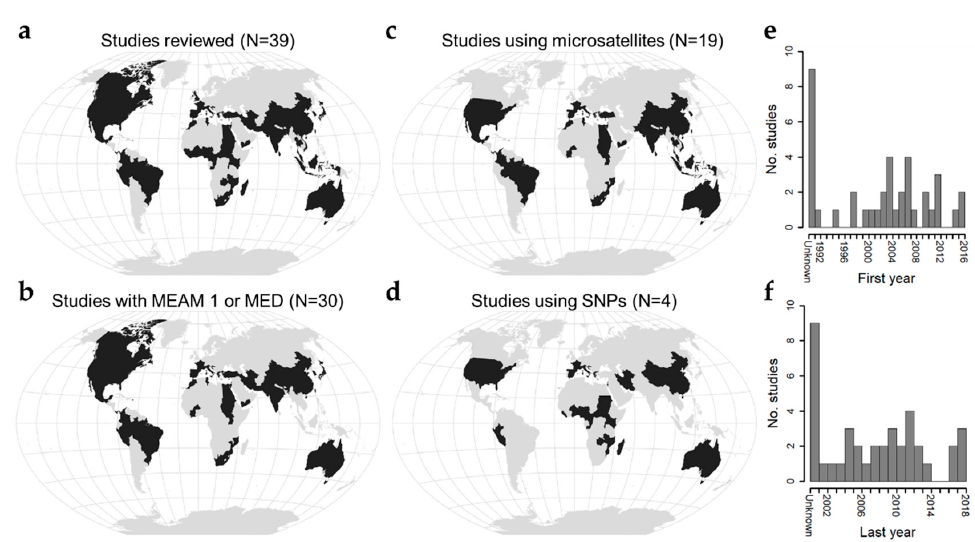
Figure 1. Geographic and temporal scope of literature reviewed. ( a ) Countries where Bemisia tabaci populations were sampled in the reviewed literature (number of studies = 39). ( b ) Countries where Middle East-Asia Minor 1 (MEAM 1) and / or Mediterranean (MED) cryptic species were sampled (number of studies = 30). ( c ) Countries where microsatellite data were used to study B. tabaci genetic variation (number of studies = 19). ( d ) Countries where single nucleotide polymorphism data were used to study B. tabaci genetic variation (number of studies = 4). Maps were drawn using the Winkel Tripel projection. ( e ) Histogram depicting the first year when sampling was reported (range 1991–2016). Studies that did not report sampling dates appear on the left and are labeled as “Unknown”. ( f ) Histogram depicting the last year when sampling was reported in studies (range 2002–2018).